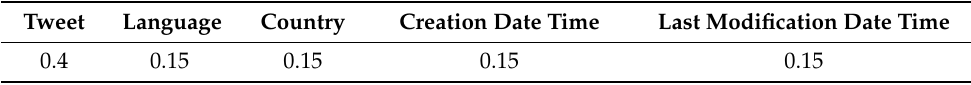
Table 7. Fields’ Weights.